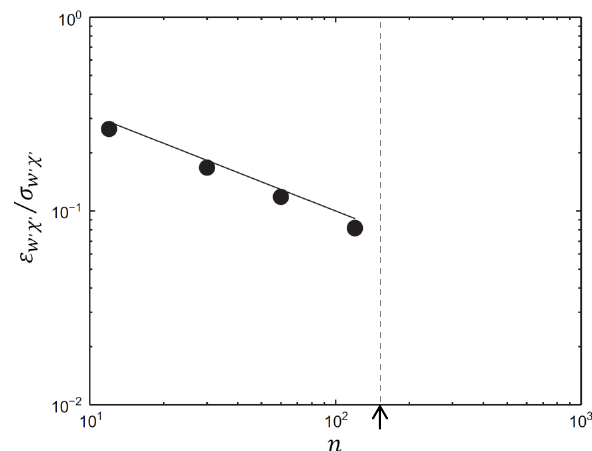
Fig. 1. Evolution of the accuracy of the DEC flux estimate according to the number of values over the averaging period. The solid line is the theoretical flux uncertainty according to Eq. (4). The filled circles represent the uncertainties on DEC fluxes simulated from sub-sets of 12, 30, 60 and 120 samples. The dotted line indicates the number of samples produced by MEDEE with a sample capture every 11.5s. Reproduced and adapted from Rinne et al.